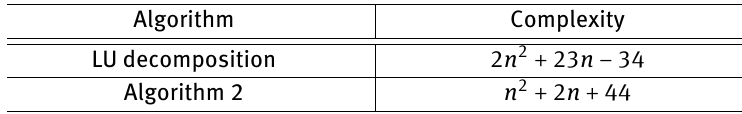
Table 2: The complexity comparison of computing inverse for different